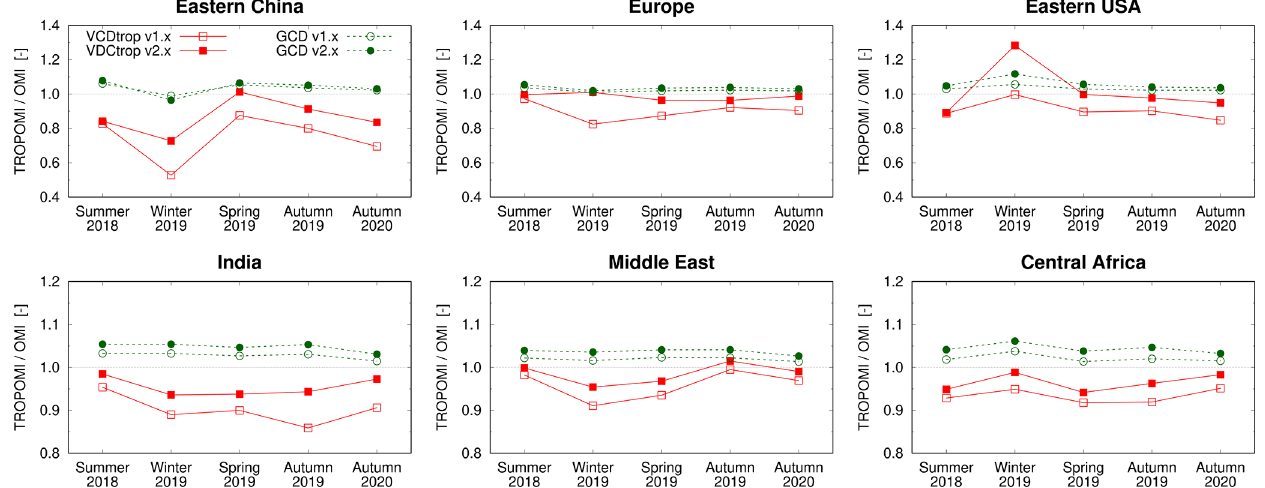
Figure 14. Regional averages of the gridded NO 2 tropospheric VCD (solid red lines) and GCD (dashed green lines) averaged over the VCD part for the five DDS periods of TROPOMI v1.x (filled symbols) and v2.1 (open symbols) divided by the respective averages of OMI/QA4ECV data. Note the difference in y -axis range of the upper and lower panels. The regions are defined in Table